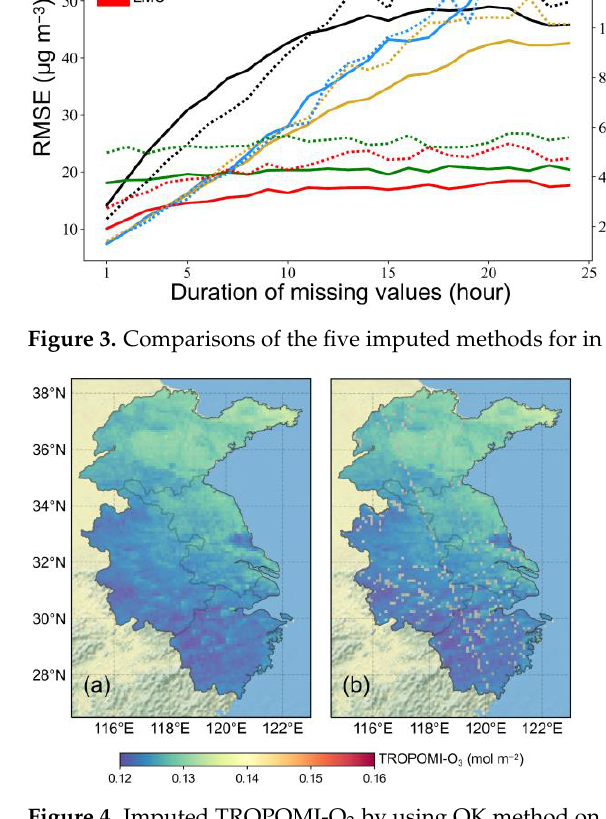
Figure 4. Imputed TROPOMI-O 3 by using OK method on 11 June ( a ) and original data ( b ).